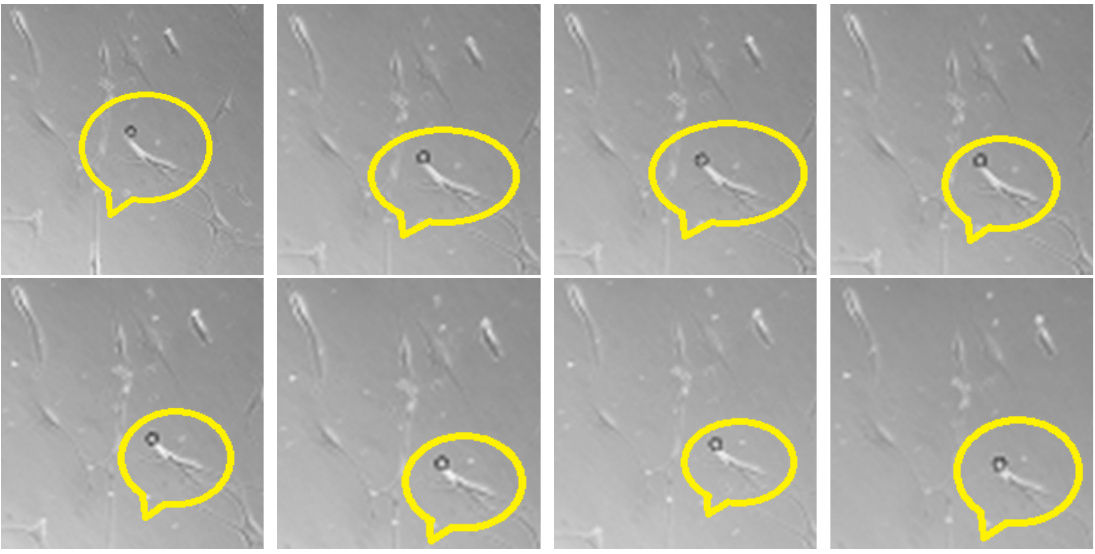
Figure 7. The black circle (inside the emphasized region) represents the center of the kernel that tracks the white cell. The order of frames is from left to right and from top to bottom. It is seen that the cell is shrinking with each frame and the kernel converges to the center of the cell.